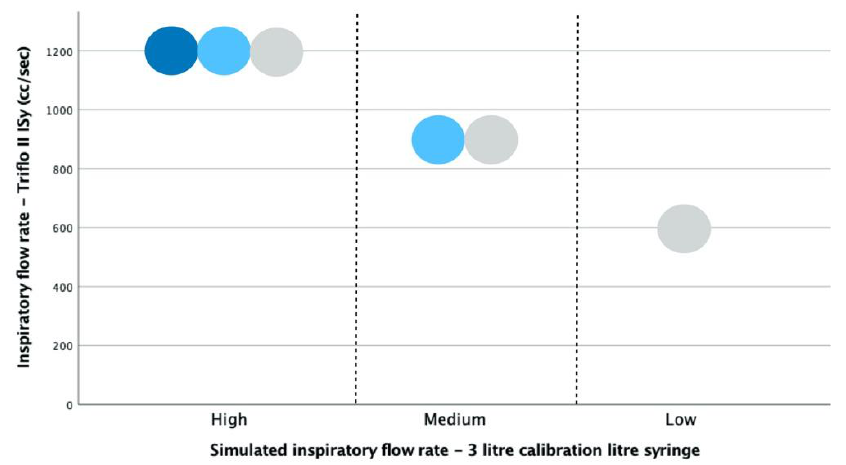
Figure 3. Triflo II ISy device — sphere(s) deflected with increasing inspiratory flow.